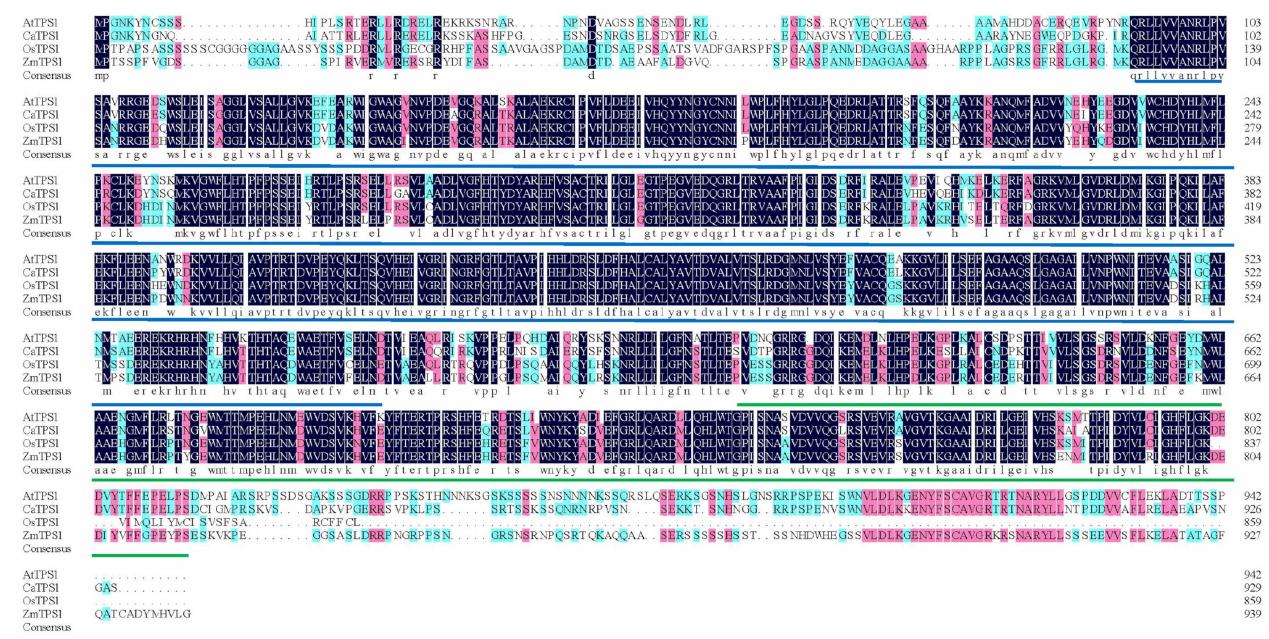
Figure 1. Alignment of pepper (CaTPS1), Rice (OsTPS1), Arabidopsis (AtTPS1) and maize (ZmTPS1) protein sequences. The TPS domain is underlined in blue and TPP domain in green. Amino acid residues with 100% similarity in all sequences are shaded in dark blue, while letters with greater than or equal to 75% similarity are shaded in pink and greater than or equal to 50% similarity in